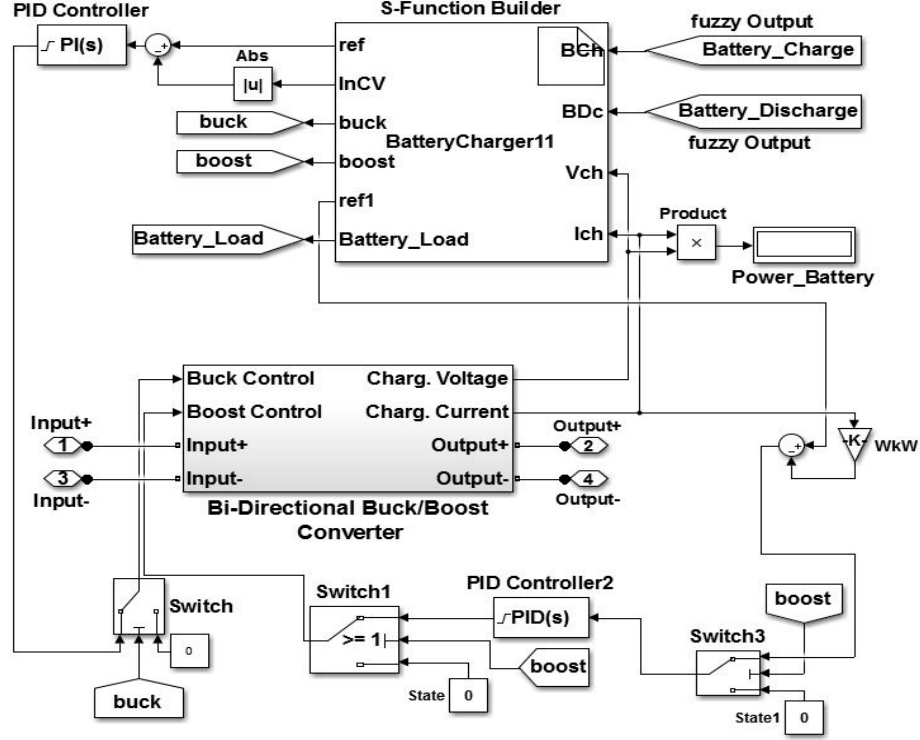
Figure 5 . Battery charging and discharging controller. Figure 5. Battery charging and discharging